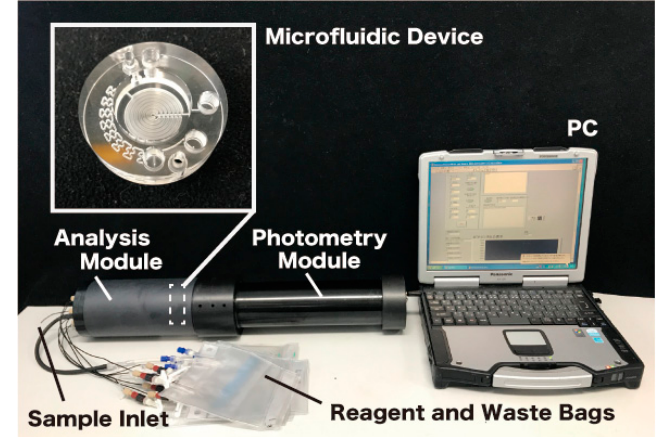
Figure 2. The in-situ adenosine triphosphate (ATP) analyzer and the microfluidic device developed